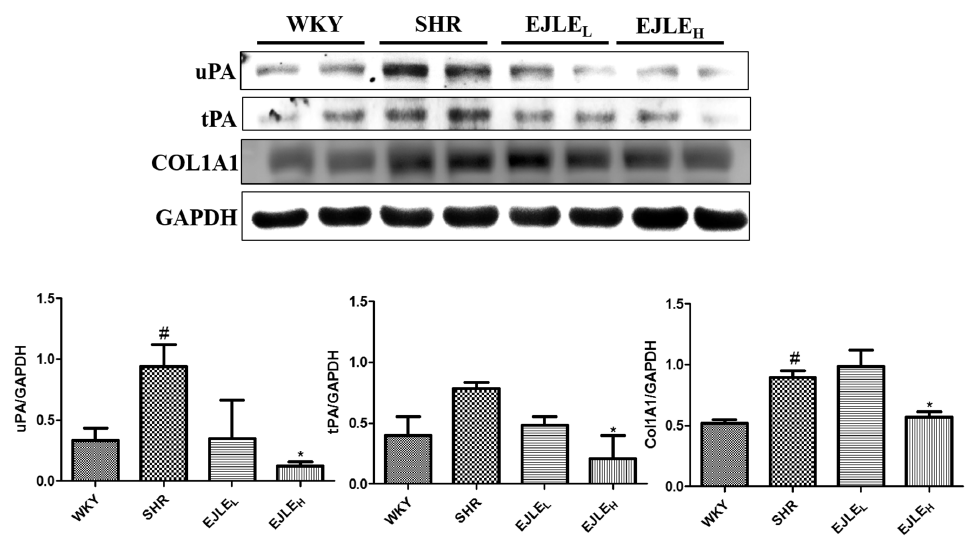
Figure 6. Effect of EJLE on the fibrosis associated proteins in the heart tissue section of SHR animals. Representative Western blot depicting the changes in the levels of COL1A1, tPA, and uPA proteins involved in fibrosis in normotensive rats (WKY), spontaneously hypertensive rats (SHRs) and SHRs supplemented with low dose (EJLE L ) and high dose (EJLE H ) of EJLE. Results were analyzed by one-way ANOVA using Tukey test with GraphPad Prism software (Version 5.0). # ( p < 0.05) indicate significant differences when compared to normotensive WKY group (SHR vs. WKY); whereas * ( p < 0.05) indicate significant differences when compared to SHR group.